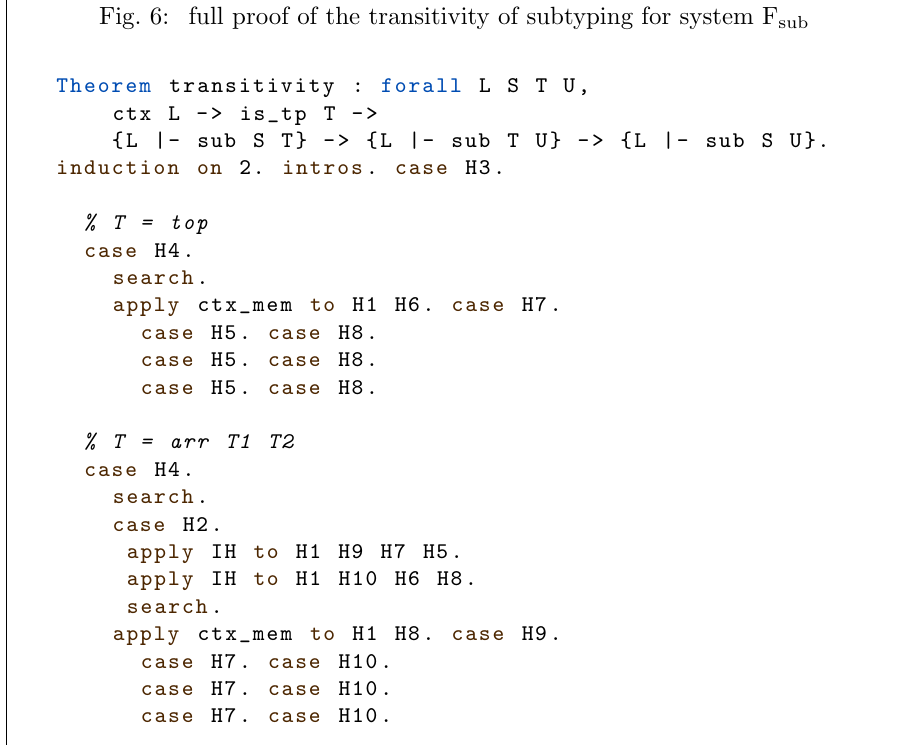
Fig. 6: full proof of the transitivity of subtyping for system F